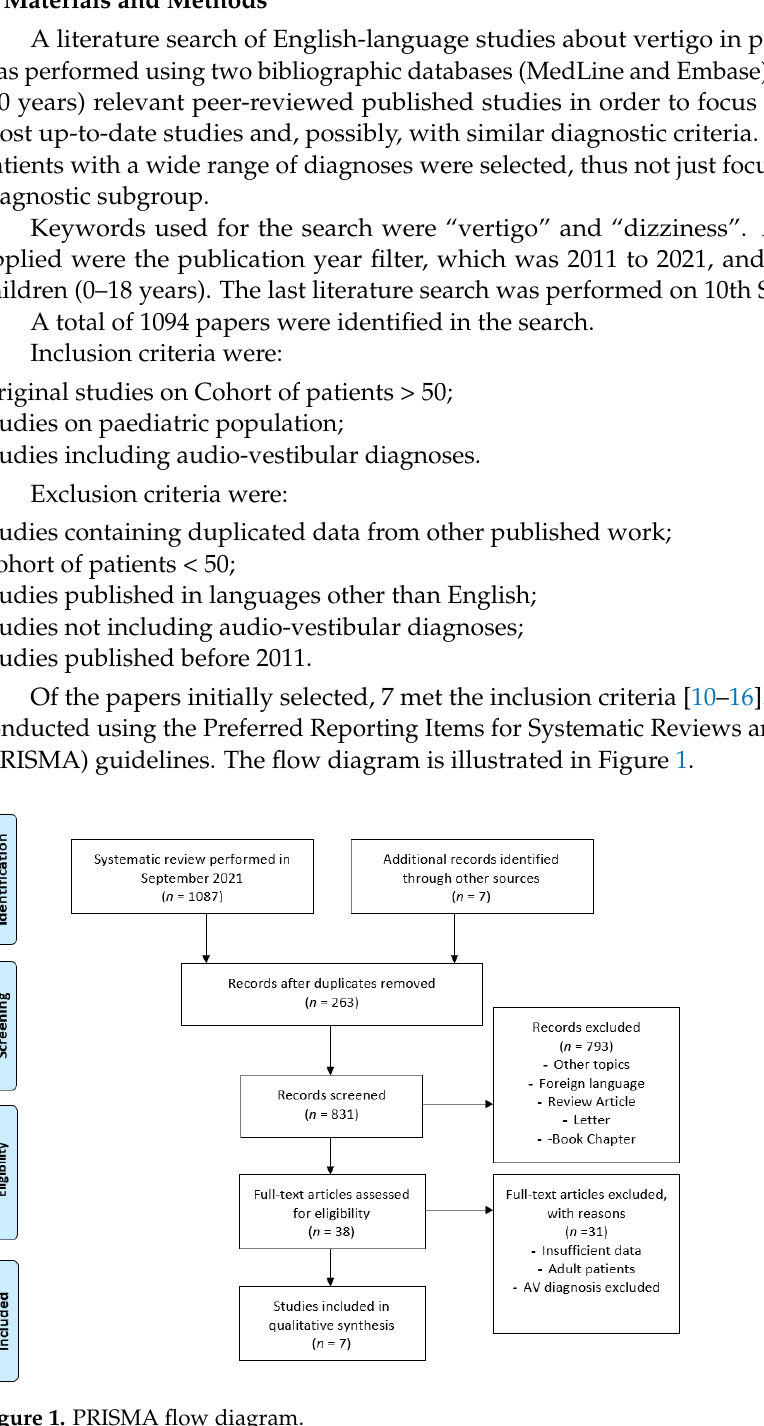
Figure 1. PRISMA flow diagram.